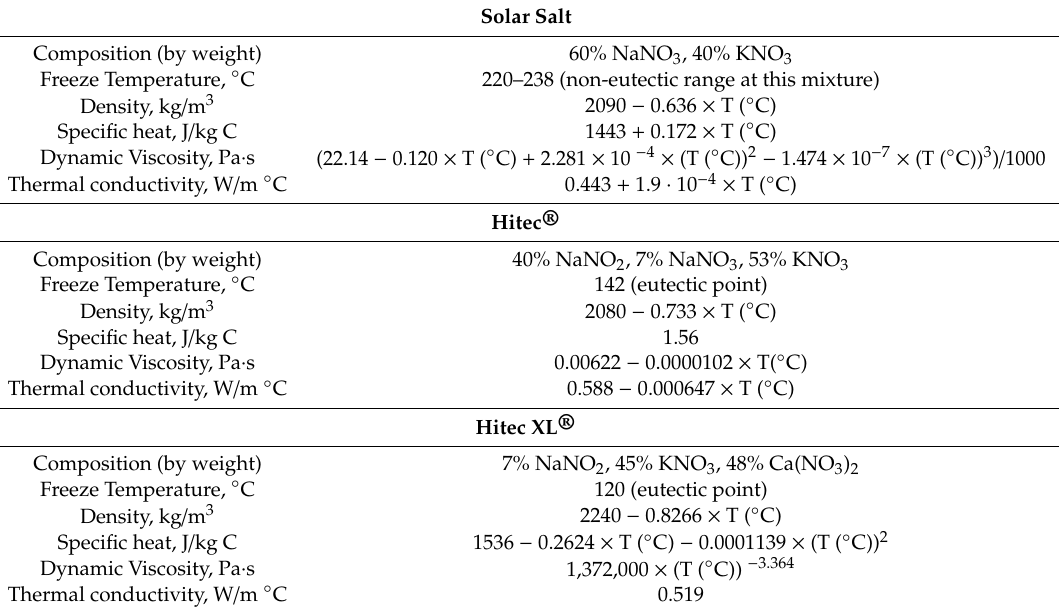
Table 1. Properties of the three heat transfer fluid (HTF) candidates